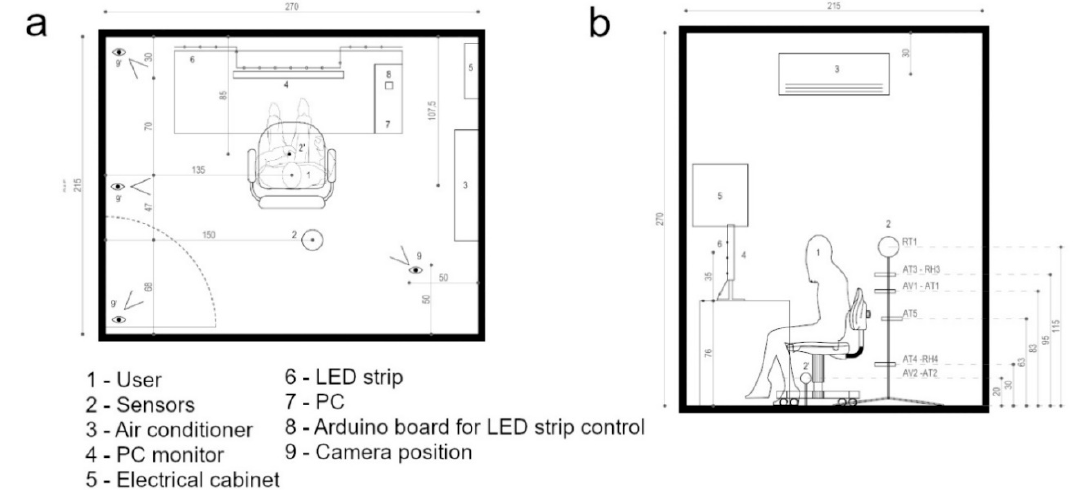
Figure 3. Distribution of the hardware in the test cell: ( a ) plant; ( b ) cross-section.